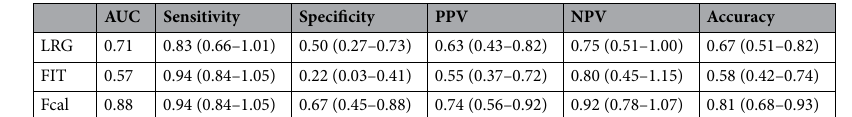
Table 5. Sensitivity, specificity, and predictive values of the serum/fecal biomarkers for mSES-CD 0 in CD patients with normal CRP levels (n = 36). Normal CRP: CRP ≤ 0.2 mg/dL. mSES-CD modified simple endoscopic score for Crohn’s disease, CD Crohn’s disease, AUC area under curve, PPV positive predictive value, NPV negative predictive value, LRG leucine-rich alpha-2 glycoprotein, FIT fecal immunochemical test, Fcal fecal calprotectin, CRP C-reactive